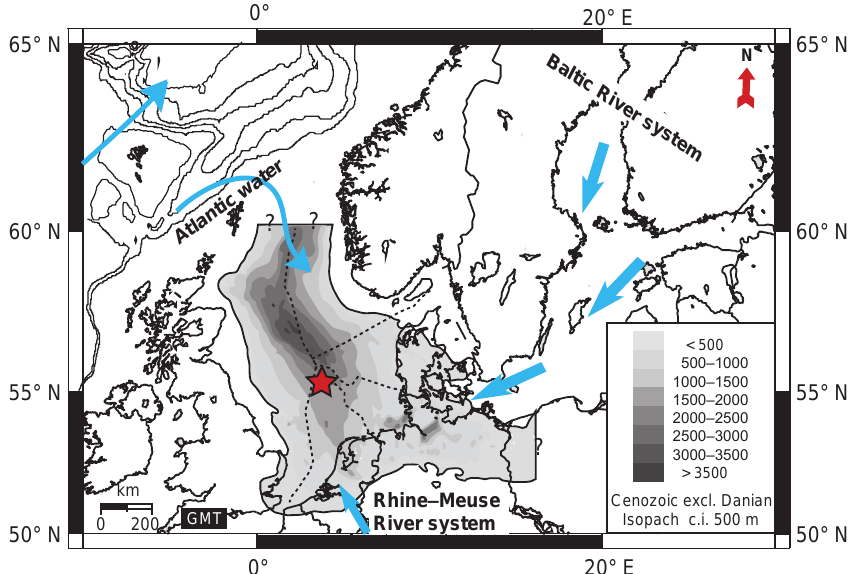
Figure 1. Geographical map of the present-day North Sea region with the superimposed thickness of Cenozoic sediment infill after Ziegler (1990) and the offshore sectors (dashed lines). The reconstructed different water sources (see Gibbard and Lewin, 2016) that in- fluenced the Pliocene and early Pleistocene North Sea hydrography, including the freshwater supply of the Baltic River system, the Rhine– Meuse River system, and Atlantic surface waters, are indicated with blue arrows. The location of both boreholes A15-3 (UTM X 552567.1, Y 6128751.6) and A15-4 (UTM X 557894.4, Y 6117753.5) is marked by an asterisk; see Fig. S1 in the Supplement for